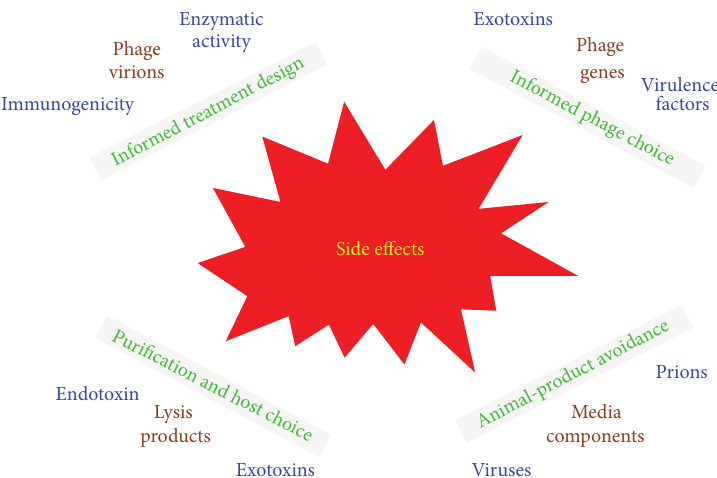
Figure 9: Summary of secondary pharmacodynamic concerns that are peculiar to phage- or protein-based antibacterial therapy. Issues are listed in brown at the corners of the figure, with more specific considerations listed in blue. Means by which these issues can be mitigated are presented as green blocks of text as found between concerns and the indication of “Side effects” shown in the center. Thus, for example, the issue of bacterial lysis products in phage formulations may be mitigated through a combination of informed bacterial choice in some combination with sufficient post-lysis purification of resulting